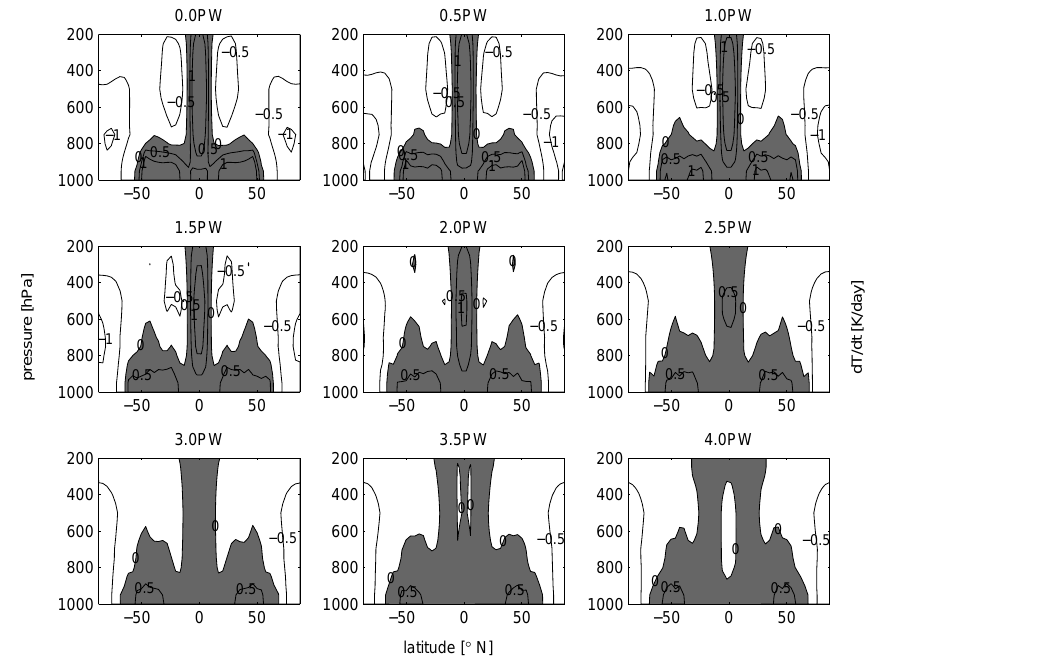
Figure 6. Zonally averaged mean heating rates in the atmosphere for oceanic heat transport ranging from 0.0PW (top left panel) to 4.0PW (bottom right panel), where grey-shaded areas indicate positive and white areas negative heating rates in Kday − 1 .